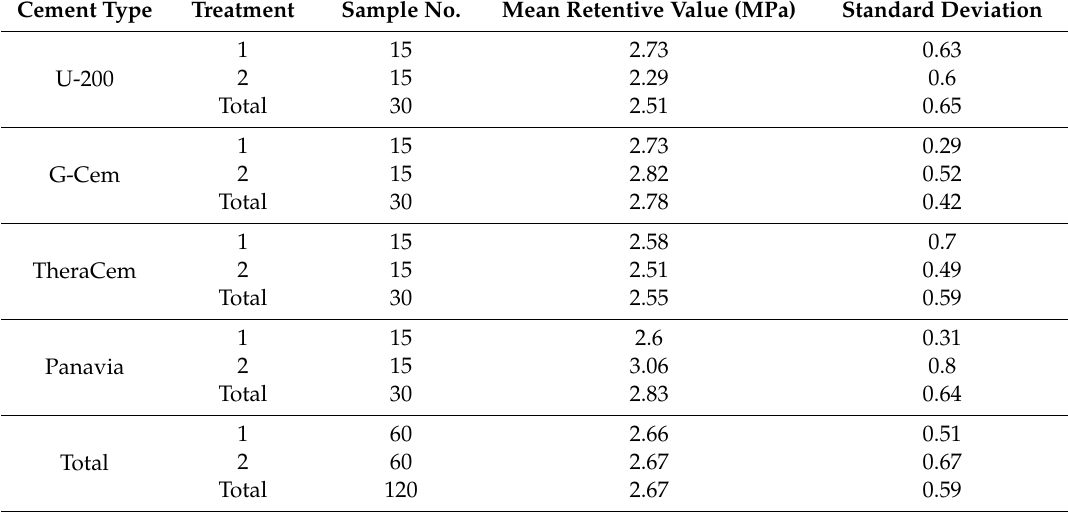
Table 2. Mean (SD) of the retentive strength (MPa) of the zirconium oxide (Y-TZP) crown-copings for the 4 types of self-adhesive resin cements (SARC) groups pre-aging and